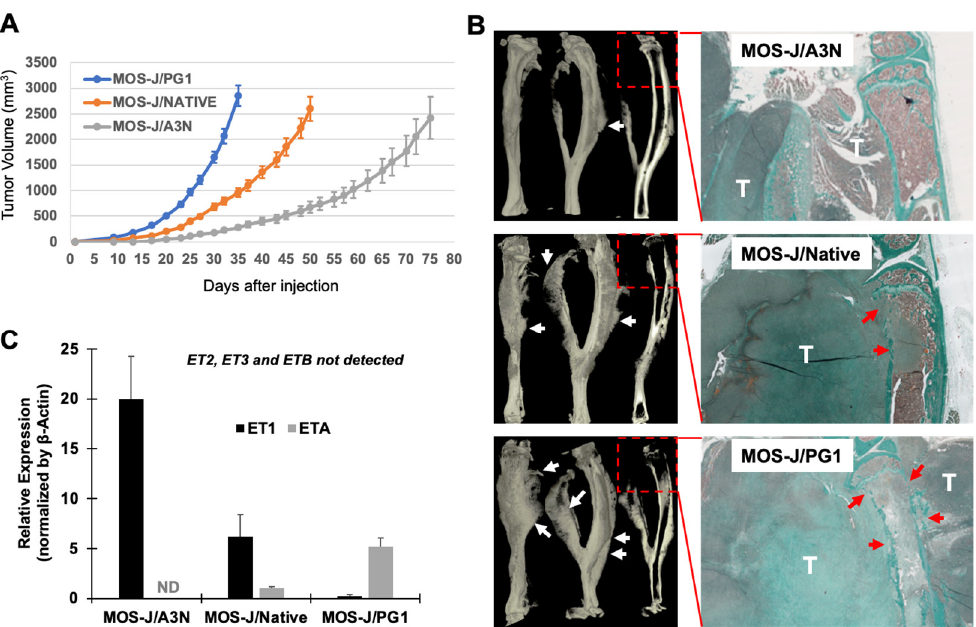
Figure 1. Comparative analyses of tumor growth, associated bone resorption and tumoral osteoid tissue formation between the three MOS-J osteosarcoma in vivo models and their relative expressions of ET1 and ETA. The MOS-J/PG1 cells showed a highly aggressive profile in contrast to the MOS- J/A3N cells, which were less aggressive in terms of tumor growth ( A ), bone resorption (red arrows in the histological views of ( B )), and tumoral osteoid tissue formation (white arrows on micro-CT views of ( B )). RT-qPCR analyses demonstrated that only ET1 and ETA were significantly detected in these cultures of MOS-J cell lines (A3N, Native, and PG1). ETA was highly expressed in the most aggressive cells and on the contrary ET1 in the less aggressive cells ( C ). T: tumor; and ND: not detected.